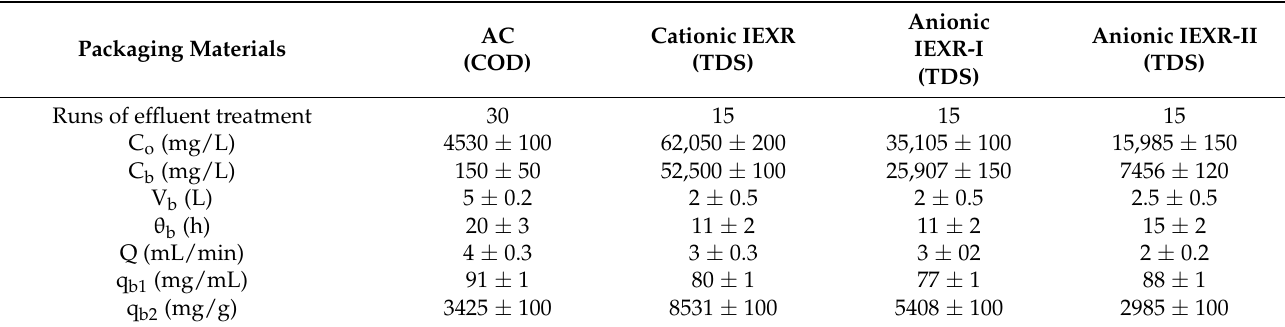
Table 3. Data of removal contaminants capacity of packaging materials (AC and IEXR) during industrial effluent treatment in columns with 20 cm of bed height.